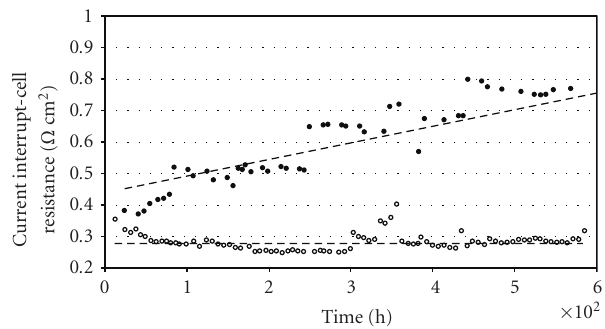
Figure 2: Current interrupt resistance versus time plot for MEA with N112 ( • ) and Nafion/MMT ( ◦ ) at 250 mAcm − 2 . the voltage was kept constant up to about 300 hours. In the